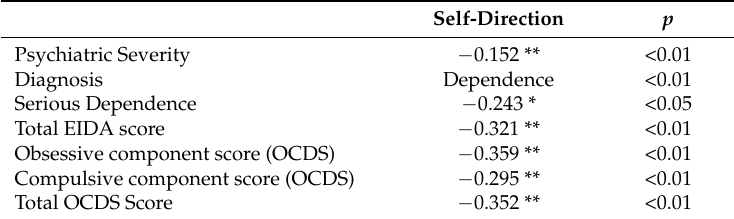
Table 5. Statistically significant correlations between SD (TCI-R) and severity factors of the EIDA, OCDS and EuropAsi scales. (* p < 0.05; ** p < 0.001).